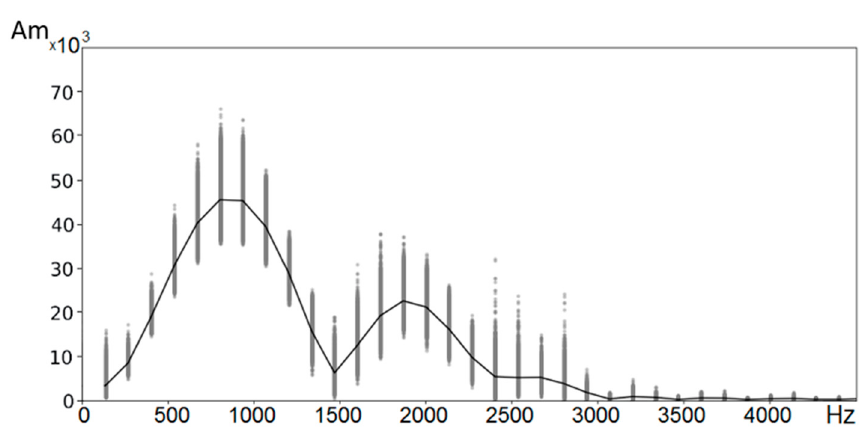
Figure 10. The values of the corrected spectra of the signals.